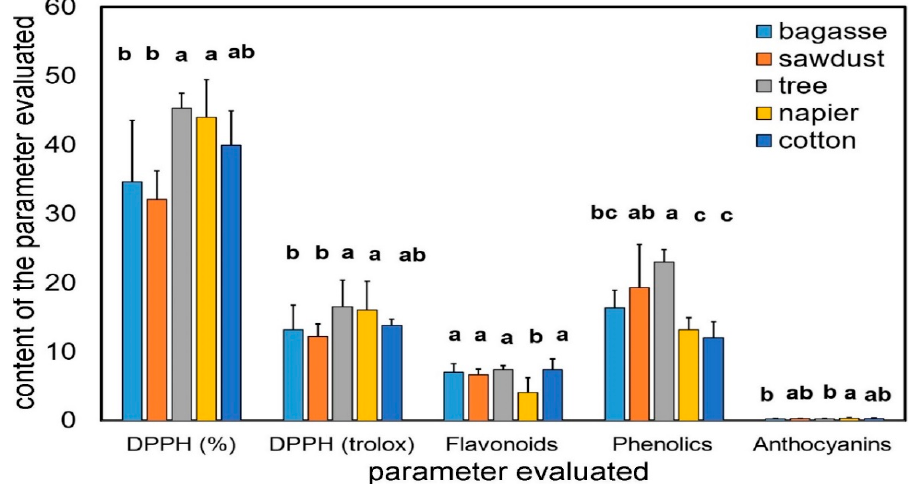
Figure 2. Antioxidant activity (DPPH in % and mg TE g − 1 ; y -axis), total flavonoids (mg CE g − 1 ; y -axis), total phenolics (mg GAE g − 1 ; y -axis), and total anthocyanins (mg CGE g − 1 ; y -axis) in shoots of parsley plants grown in medium composed of bagasse–chicken compost + biochar, sawdust– chicken compost + biochar, tree–chicken compost + biochar, napier–chicken compost + biochar, and 30, 45, and 60%, weight basis) and the average values used in statistical analyses. Error bars represent standard deviations. For each parameter, bar values followed by the same letter are not statistically different ( p < 0.05; ANOVA Duncan post-hoc test).